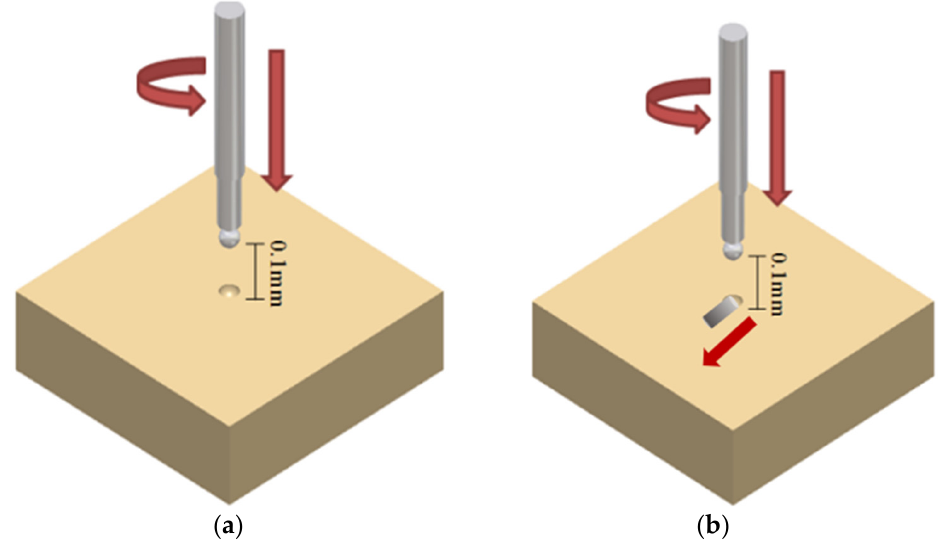
Figure 6. Two types of micro mold cavity made by ( a ) ECM drilling and ( b ) micro ECM milling.